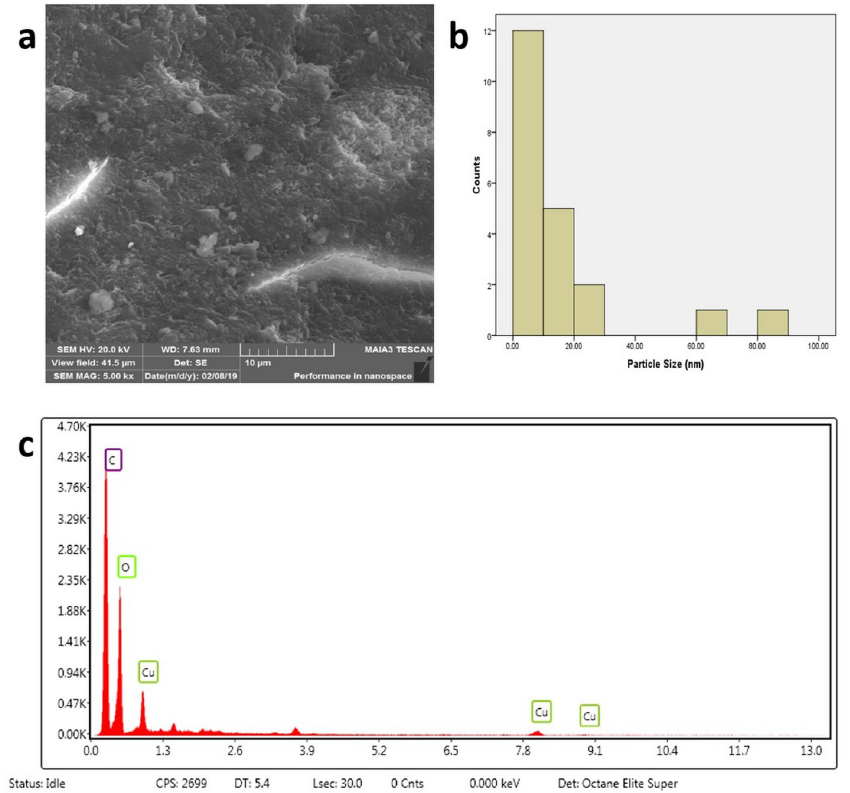
Fig 2. Characterization of CuNPs. (a) FESEM micrograph of CuNPs, showing spherical shape of CuNPs; (b) Size distribution histogram of CuNPs, showing average size of 23 nm. c EDX spectrum of CuNPs.